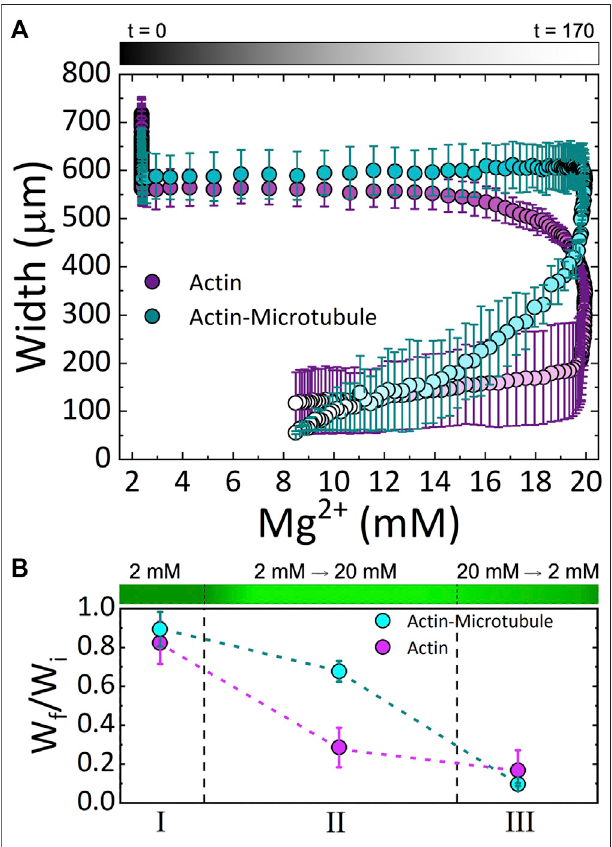
FIGURE 4 | Cytoskeleton networks exhibit network-dependent contraction in response to both increasing and decreasing Mg 2+ concentration (A) The average width of actin network samples (magenta) and actin-microtubule network samples (cyan) as a function of Mg 2+ concentration. Experimental time is indicated in the symbol gradient coloring where t (cid:2) 0 is cyan and magenta and t (cid:2) 170 is light cyan and magenta. (B) The fractional amount of contraction measured for each Phase (I, II, III; described in the text), computed by W f /W i where W i is the width at the beginning of the experiment and W f is the width at the end of the corresponding Phase. The dashed lines separating the three Phases approximate the relative length of time of each phase. The corresponding Mg 2+ concentrationisdepictedasagradientwithdarktolightgreenindicating 2 to 20 mM Mg 2+